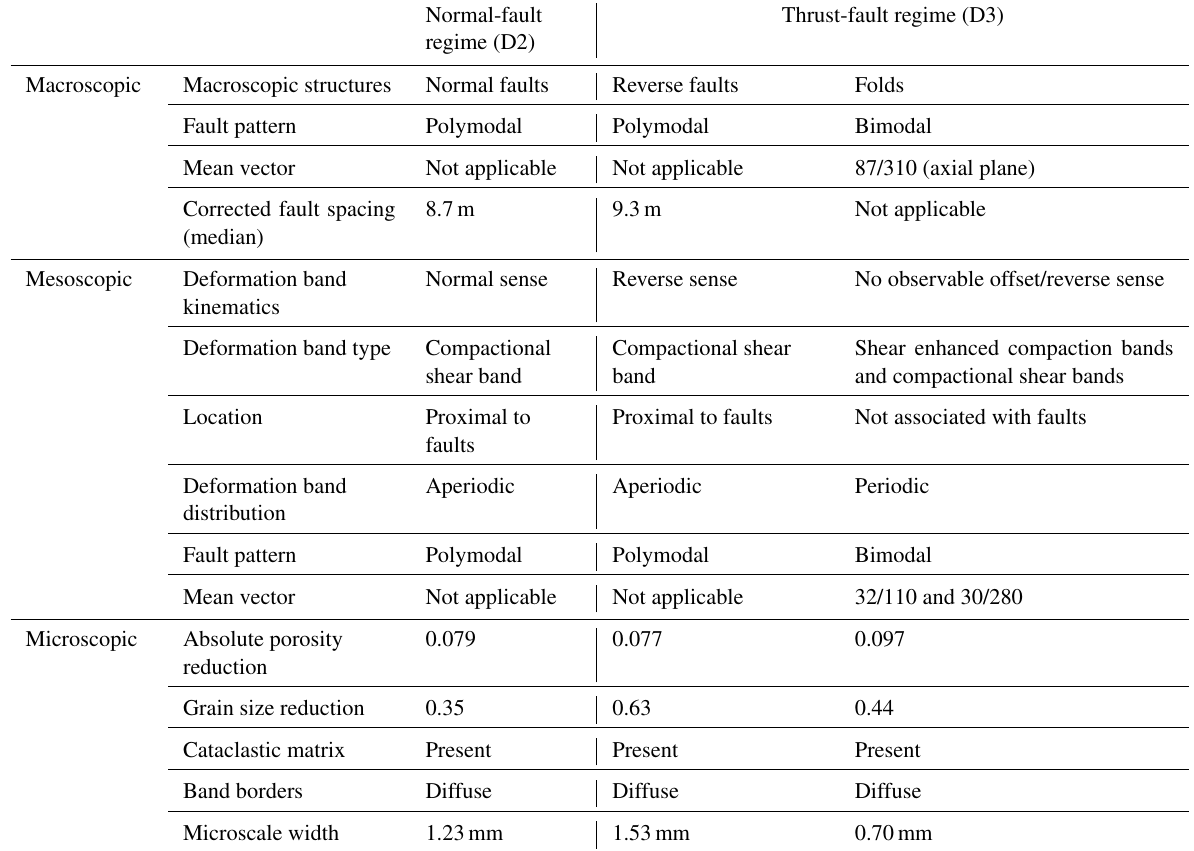
Table 1. Primary results from the analysis conducted at